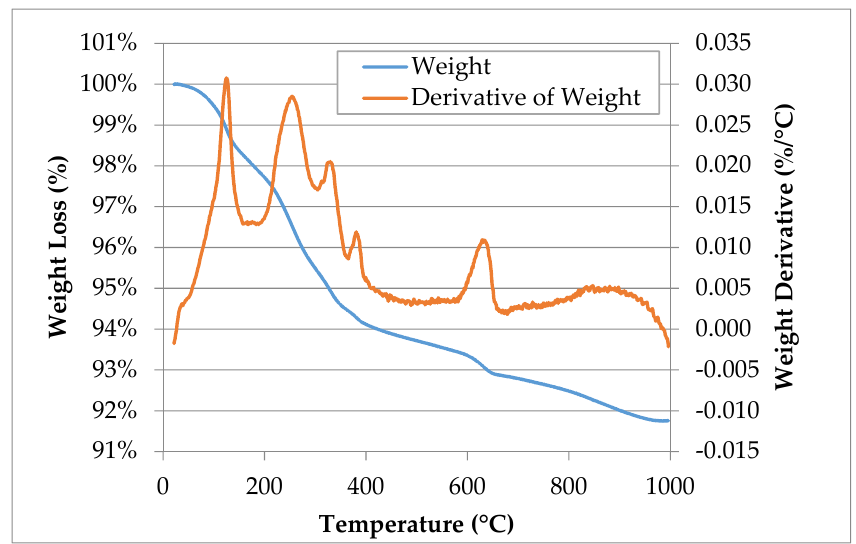
Table 6. Free lime content of the LMF slag fines.